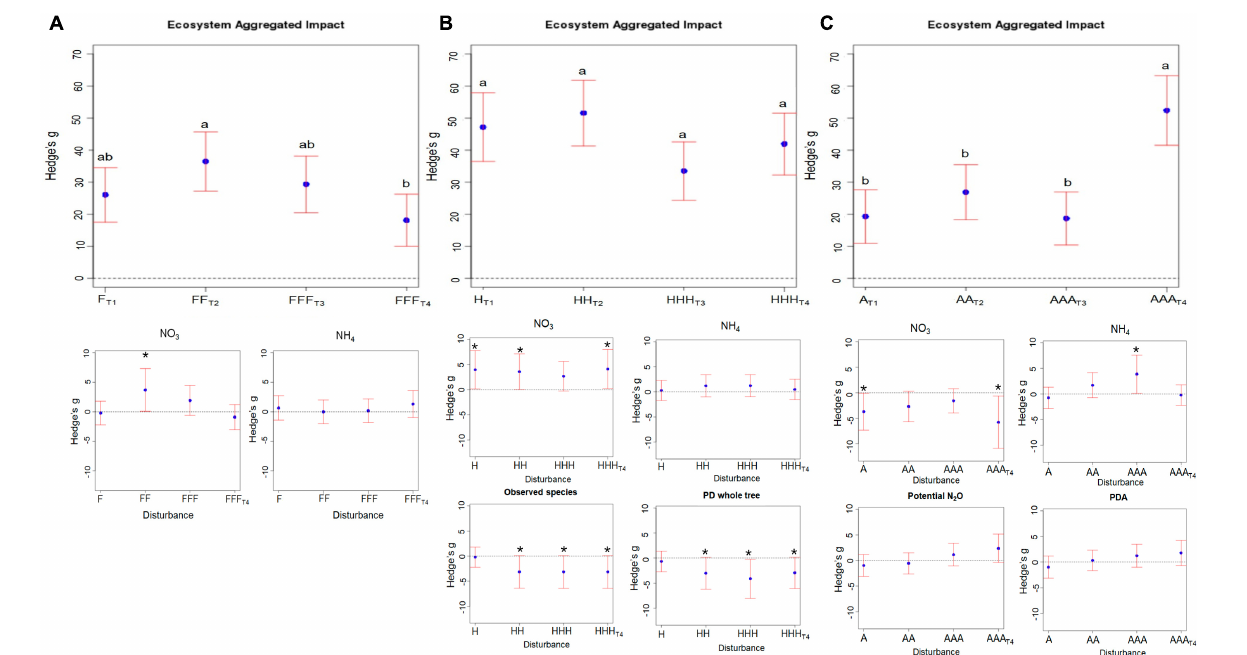
FIGURE 1 | Aggregated impact of repeated disturbances on ecosystem properties and functions. The “Ecosystem Aggregated Impact” was calculated as the sum of the absolute value of Hedges’ g for the 26 studied variables. The corresponding variance is the sum of the variance of each variable Hedges’ g. 95% confidence intervals are represented for each treatment ( A ) corresponds to the Freeze-Thaw disturbances: F; Panel B to the Heat disturbance: H; and panel C to the Anoxia disturbance: A. In each panel, the corresponding treatment effects on ammonium and nitrate pools as well as on chosen ecosystem properties and functions is given. Note that the control treatment cannot be plotted on this figure because each ecosystem functions and properties (EAI) is calculated as an effect size of a given treatment relative to the control. Different letters above the bars indicate significant differences.